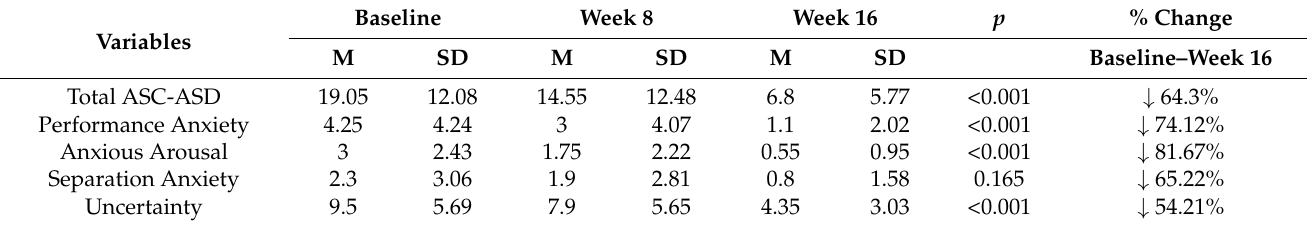
Table 3. Results for the one-way repeated-measures ANOVA or Friedman test for teacher- reported